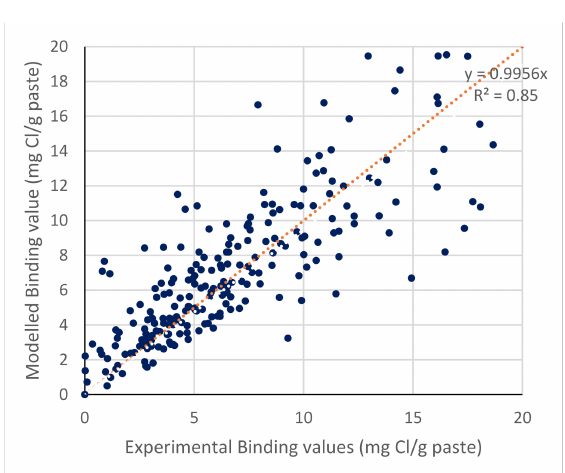
Figure 4. Linear regression analysis of the proposed binding model versus experimental results in the